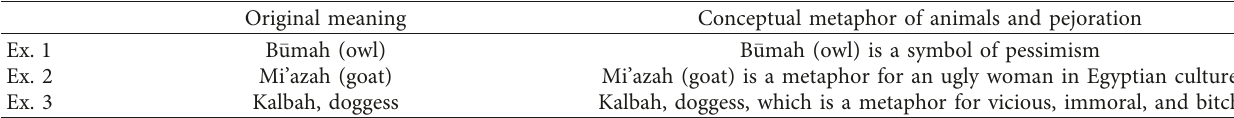
Table 4: Metaphorical extension and